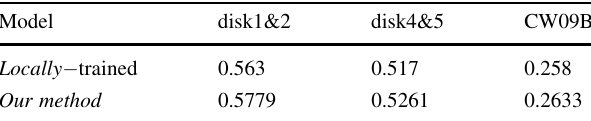
The results of the locally trained method are the best results reported in [12]. The results of our approach are obtained